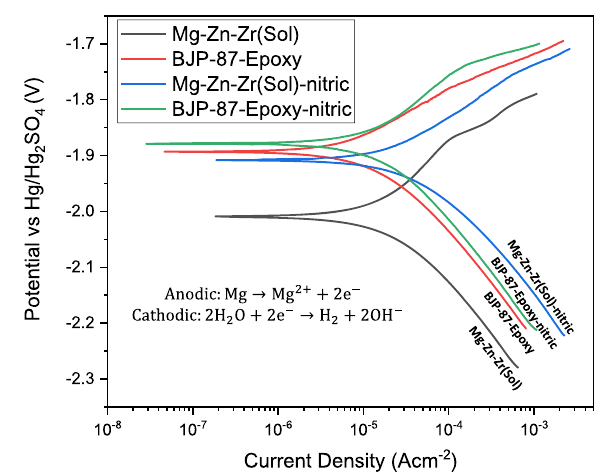
Fig. 6 Potentiodynamic polarization of solutionised and BJP Mg- Zn-Zr alloys pre and post nitric acid etch. Potentiodynamic polarization of Mg – Zn – Zr(Sol), Mg – Zn – Zr(Sol)-nitric, BJP-87-Epoxy, BJP-87-Epoxy-nitric after 30 min immersion at OCP in 0.1 M sodium sulfate solution at room temperature. Current densities for the BJP samples have been corrected for the area fraction of Mg alloy (as opposed to epoxy) exposed to the